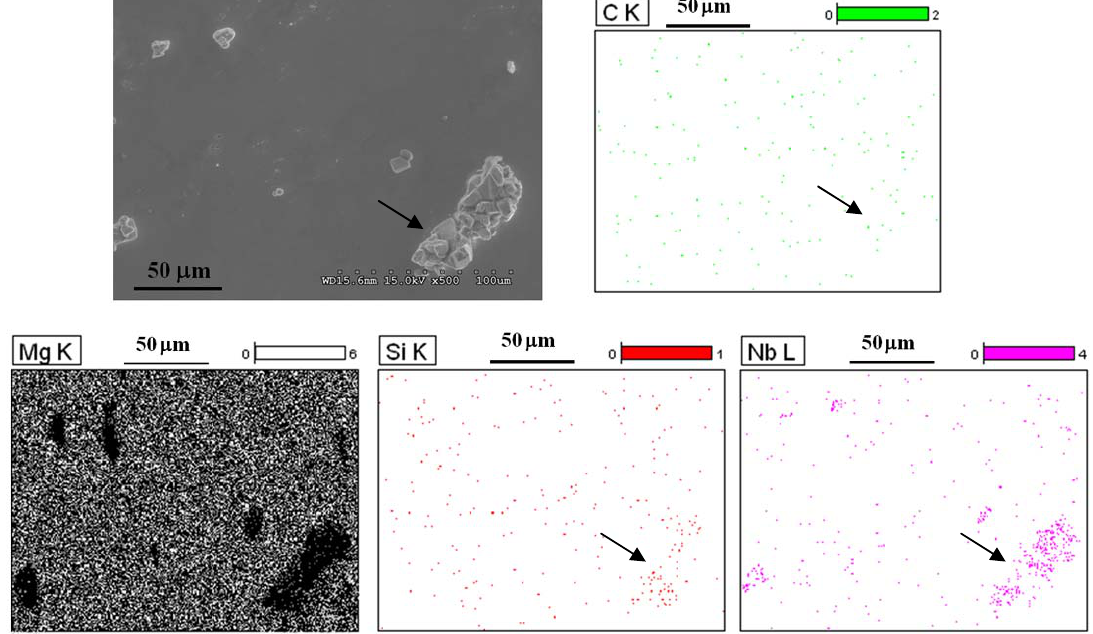
Figure 3. EDX analyses showing the x-ray mapping of C, Mg, Si and Nb in Mg-5Nb-0.25SiC (0.13% V ) composite. SiC (Si and C) is seen to be uniformly distributed n f n in the Mg-matrix and also preferentially present within the Nb-particle cluster (arrows).